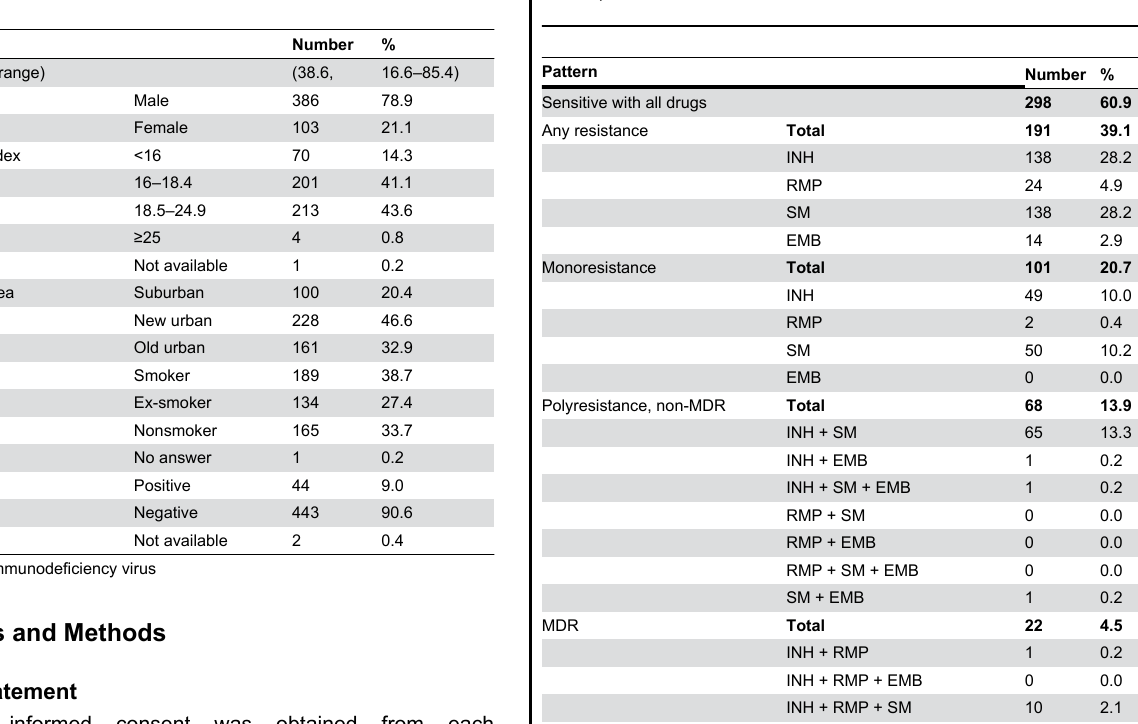
Table 1. Characteristics of the study population ( n = 489).